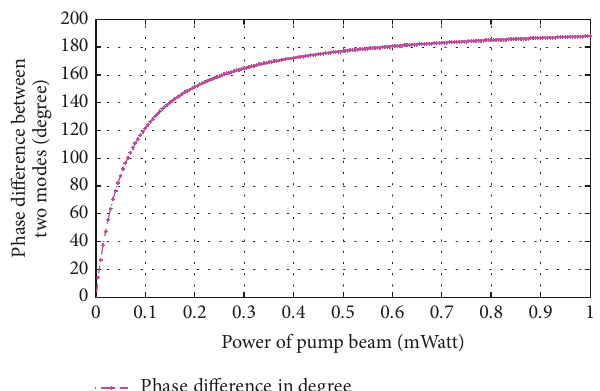
Figure 5: Variation of phase difference between TE mode and TM mode with respect to power of the input pump beam.